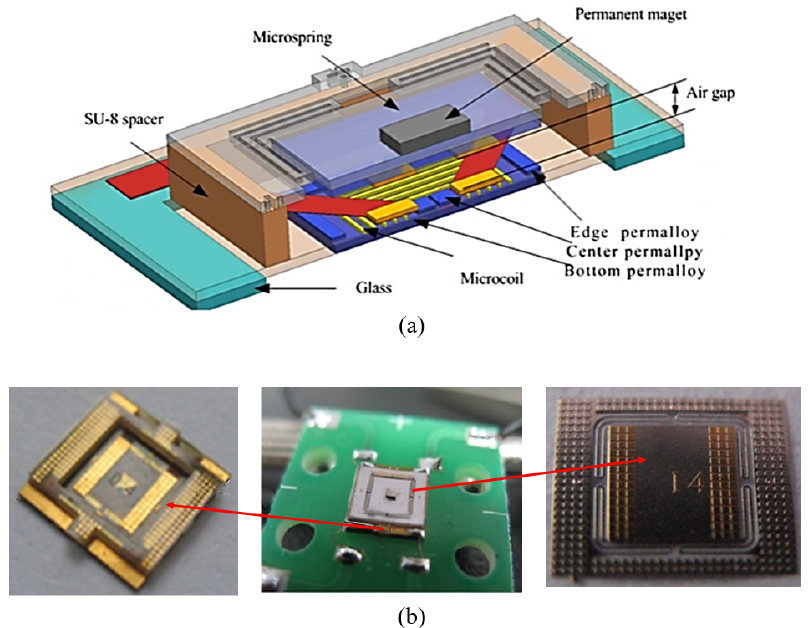
Figure 8. The bistable electromagnetic switch proposed by Miao et al. (2011 [128]): ( a ) the schematic; ( b ) the pictures of the prototype.